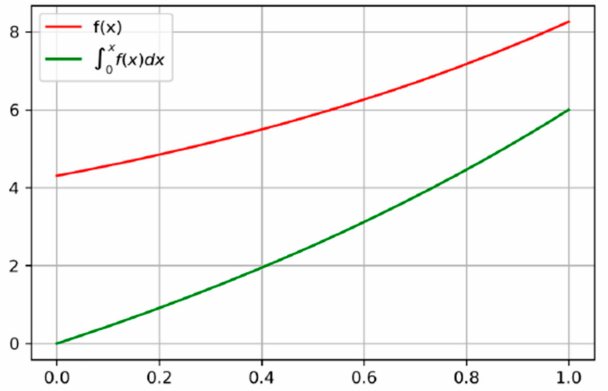
Figure 2. The value of the readiness level depends on the value of the exponent.